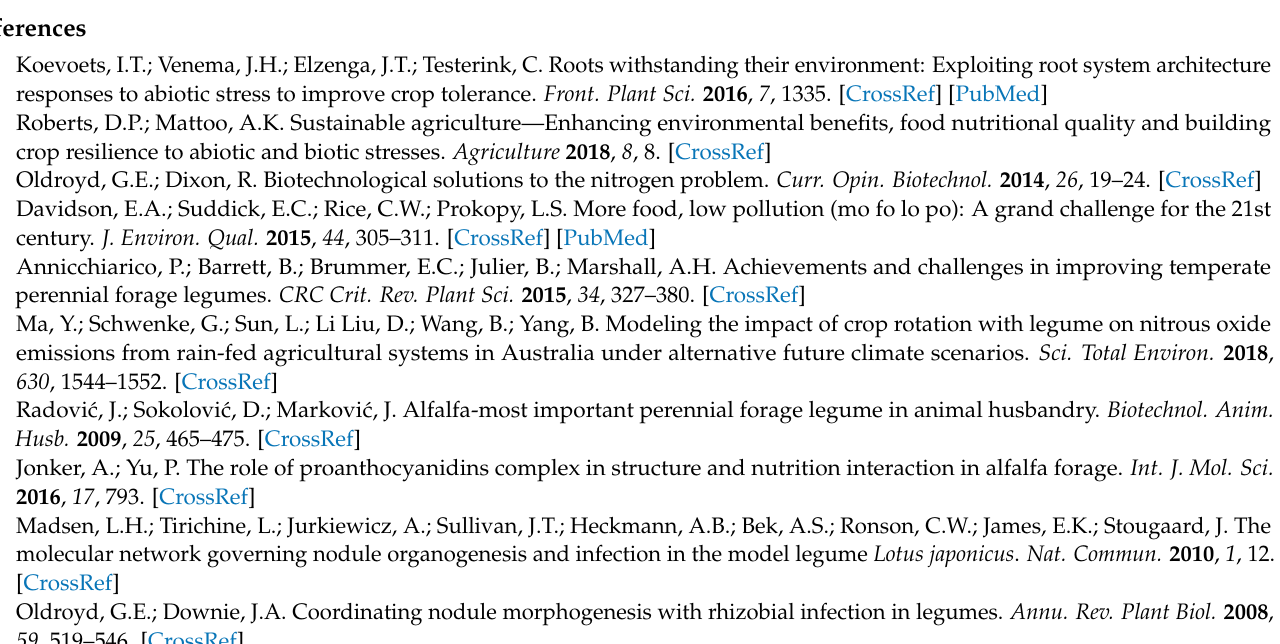
Figure S3: Promoter sequence of the alfalfa AGL21 gene with putative SBD binding elements; Table S1: List of primers used in this